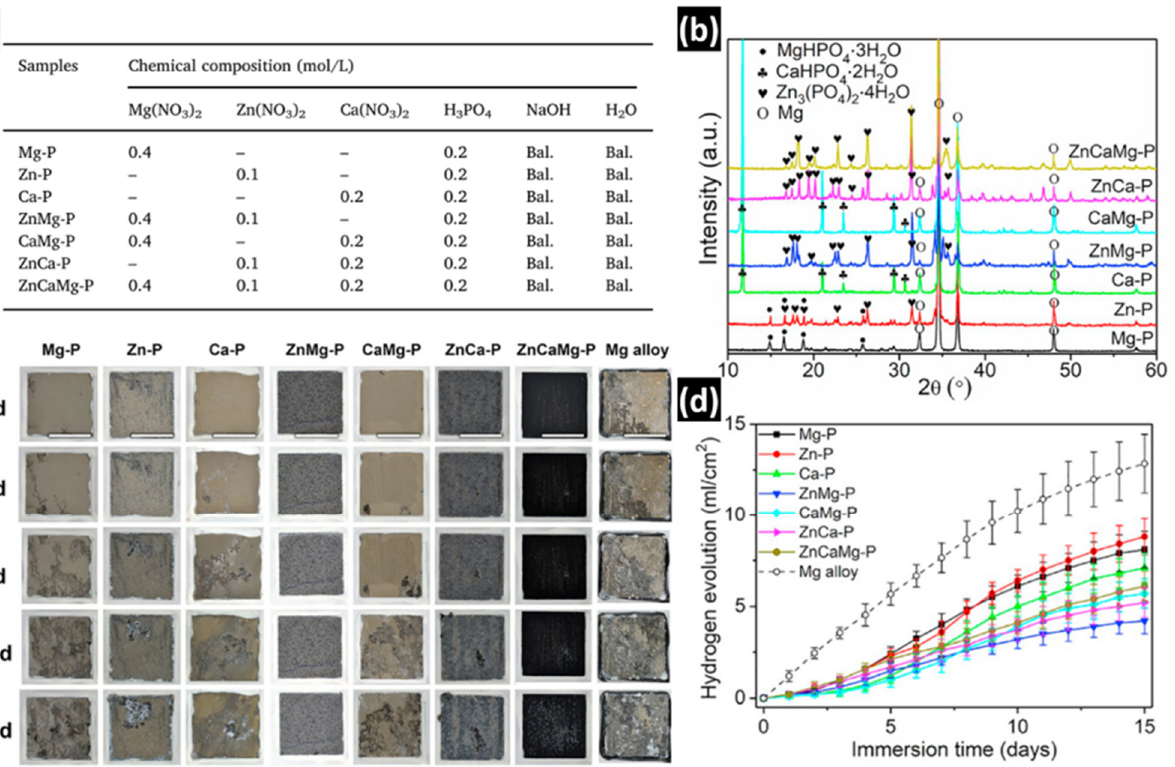
Figure 11. ( a ) Chemical composition of the phosphate conversion baths used in [150]. ( b ) The XRD patterns of the formed conversion coatings from the bath composition in ( a ) of AZ31. ( c ) Surface appearance and ( d ) hydrogen evolution of the AZ31 substrate coated with different phosphate conversion coating in ( a ) during immersion in Hank solution at 37 °C. Reprinted from [150] with permission from Elsevier.